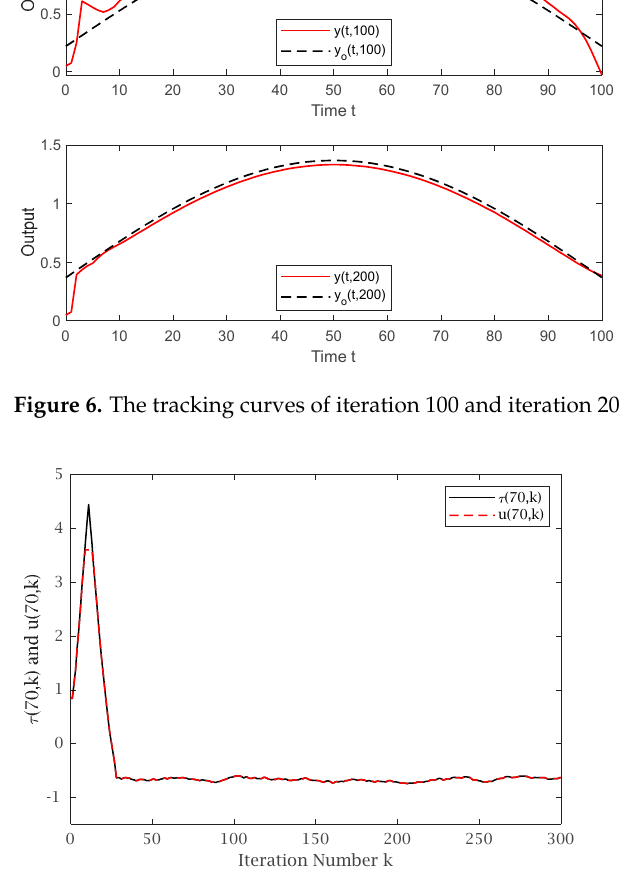
Figure 7. 𝑢 ( t , k ) and 𝜏 ( t , k ) of the input saturation (32) at t = 70.